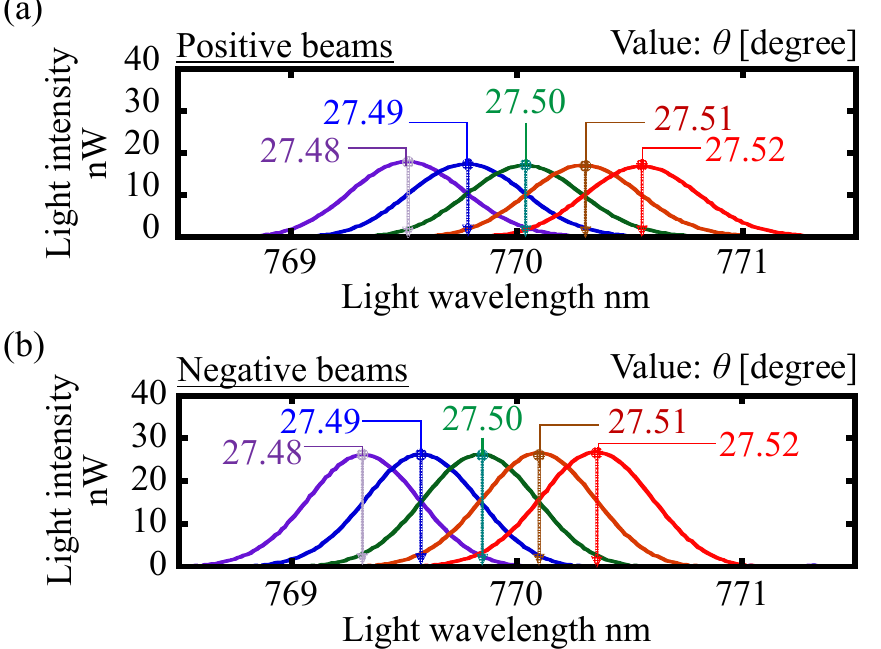
Figure 10. Spectra obtained at each angular position of the scale grating: ( a ) with the positive first-order diffracted beams; ( b ) with the negative first-order diffracted beams.